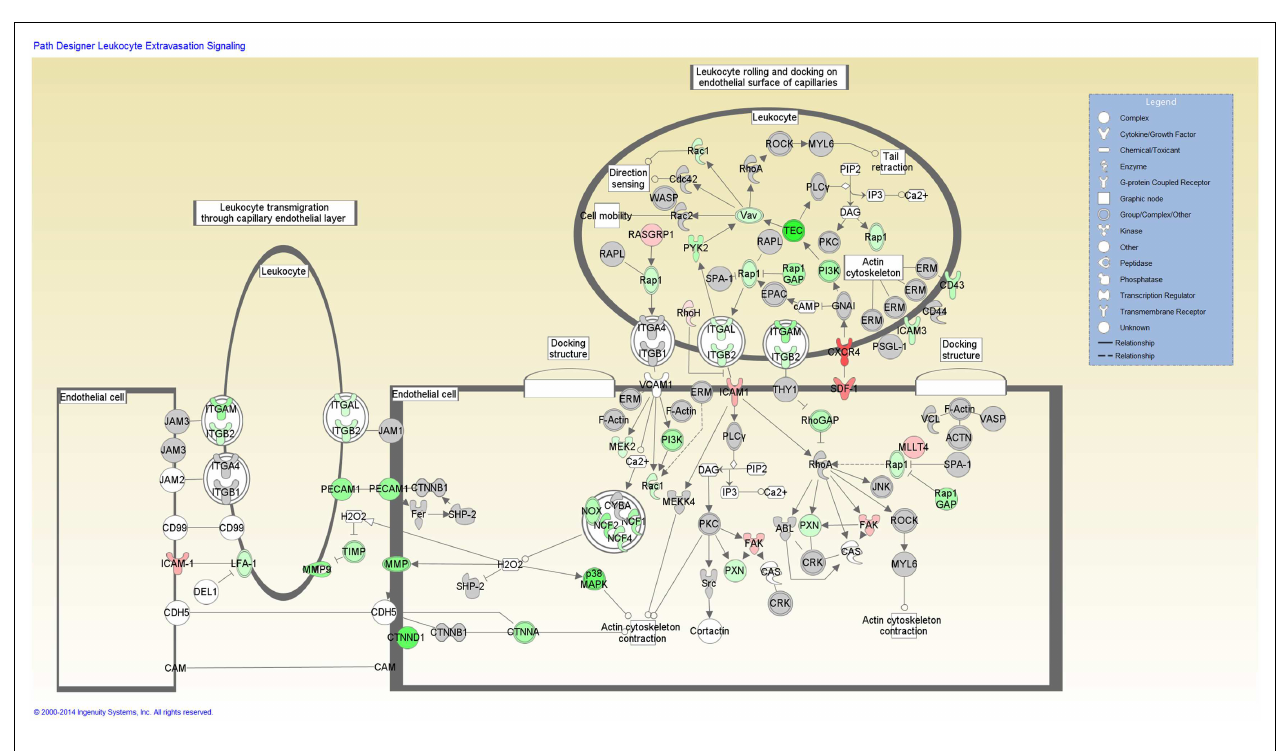
Green shading indicates decreased expression in M. bovis -infected animals relative to the non-infected control group.